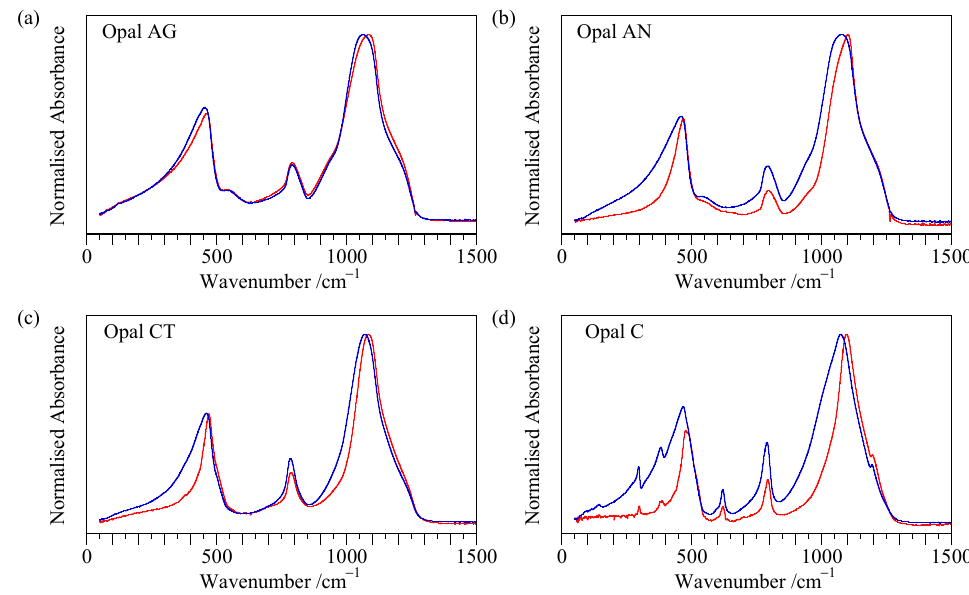
Figure 10. ATR spectra (Bruker 80v instrument) of ground samples showing selected examples of variable spectra with grinding (red less ground with blue more ground): ( a ) opal-AG (G NEW22 from Lambina, South Australia, Australia), ( b ) opal-AN (hyalite) (G8877 from Squaretop, Dalby, Queensland, Australia), ( c ) opal-CT (G9942 from Angaston, South Australia, Australia) and ( d ) opal-C (T1664 from Guanajuanto, Mexico). Spectra are depth corrected and normalised to the 1100 cm − 1 peak.